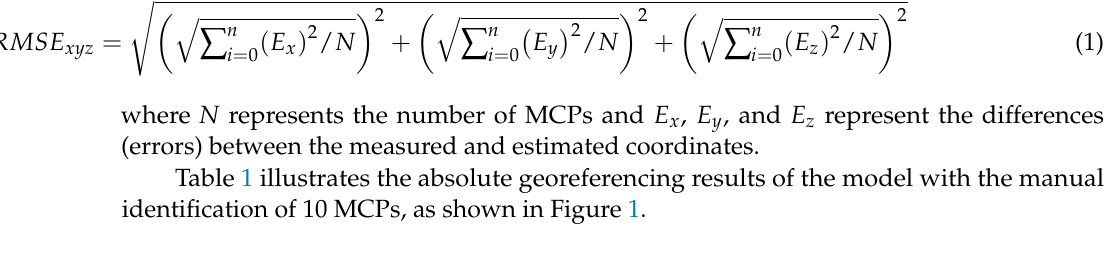
Table 1. Georeferencing accuracy of the model based on a comparison between the real and estimated X-, Y-, and Z-coordinate systems per MCP. The total RMSE is presented at the bottom of the